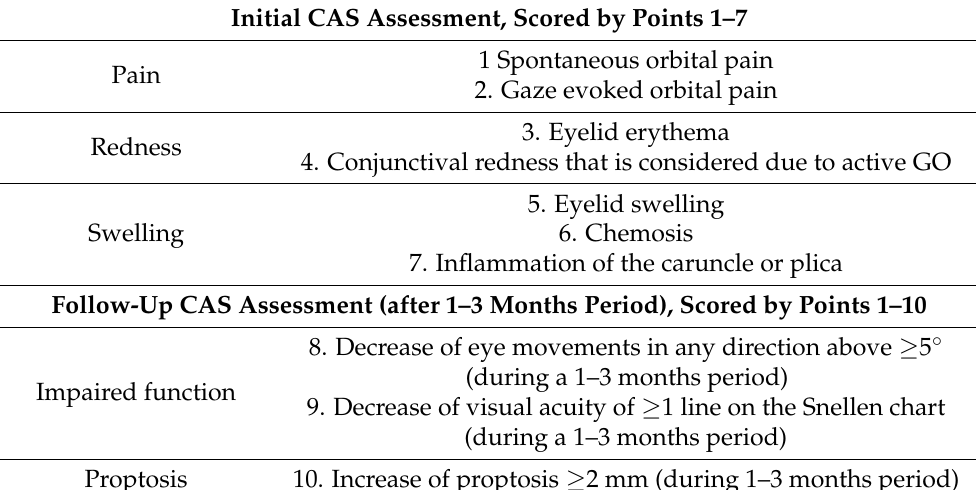
Table 2. Clinical Activity Score—CAS (amended by EUGOGO after Mourits et al.). One point is given for the presence of each of the parameters assessed, the sum defines clinical activity [9].